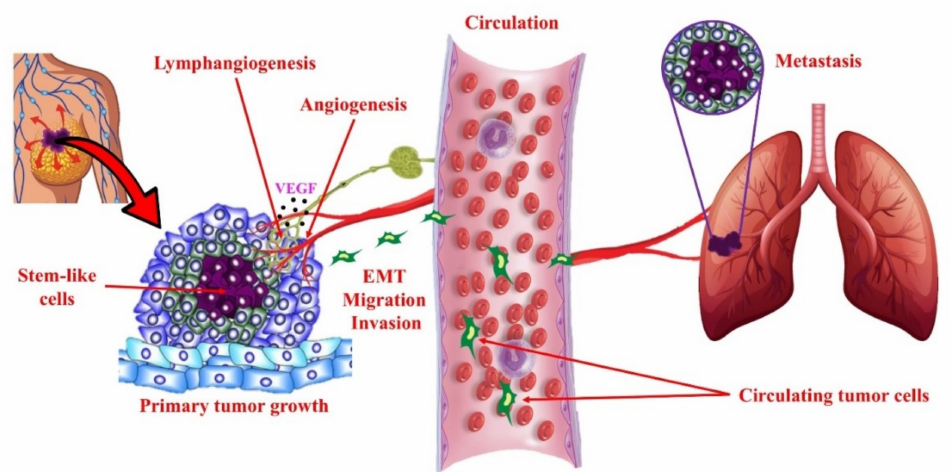
Figure 7. Schema of cellular events in tumor progression and metastasis. Primary tumor growth depends on proliferation of tumorigenic cells, some of which adopt a stem-like cell (SLC) phenotype under the influence of genetic and epigenetic (micro-environmental) mechanisms. Local tumor growth is dependent on angiogenesis (formation of new blood vessels), which also facilitates tumor cell egress into the circulation. In addition, many epithelial tumors undergo intra-tumoral and/or peri-tumoral lymphangiogenesis (formation of new lymphatic vessels) that helps tumor cells to migrate to lymph nodes and then enter circulation. Epithelial-mesenchymal transition (EMT) is a phenotypic change in epithelial tumor cells utilized for invasion and migration out of the local confines. These cellular events are stimulated in COX-2 expressing breast tumors by activation of EP4 on tumor cells and tumor-associated host cells (immune cells, endothelial cells), so that EP4 presents as a therapeutic target to block multiple cellular events in tumor